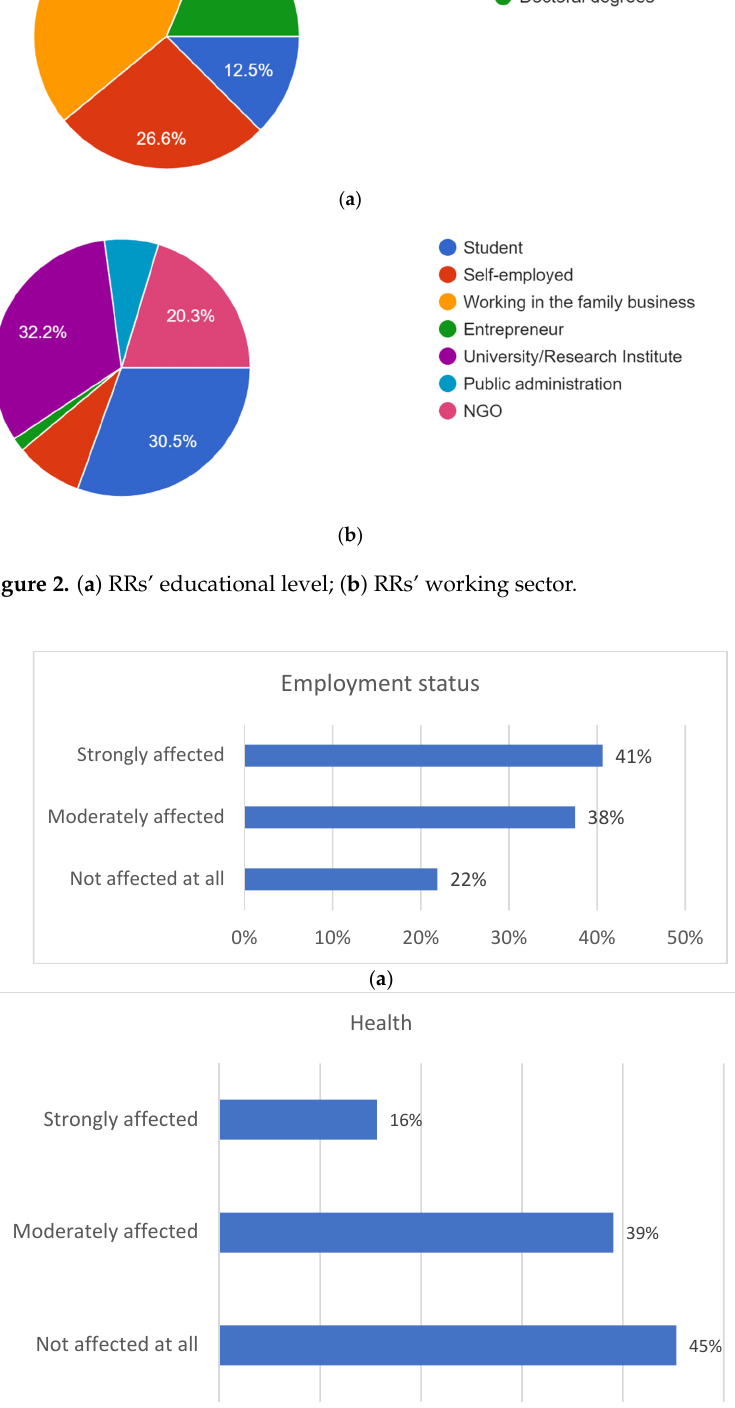
Figure 4. The two most significant difficulties in working from home (WFH). Source: online survey that took place between December 2020 and March 2021. N: 64.